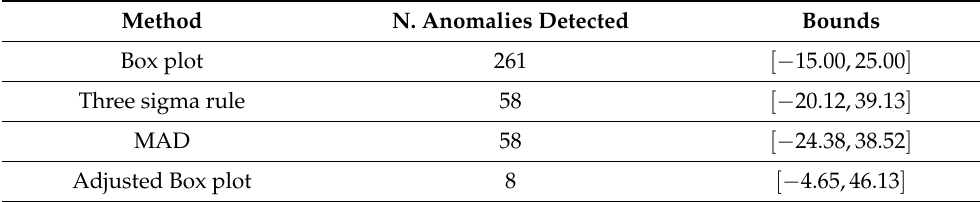
Figure 6. Choosing the anomaly detection method: ( a ) Distribution of the relative distances to the diagonal of the STM, and ( b ) CoMs of the characteristic matrices with labeled anomaly measures results. Table 1. Comparison of the multiple anomaly detection